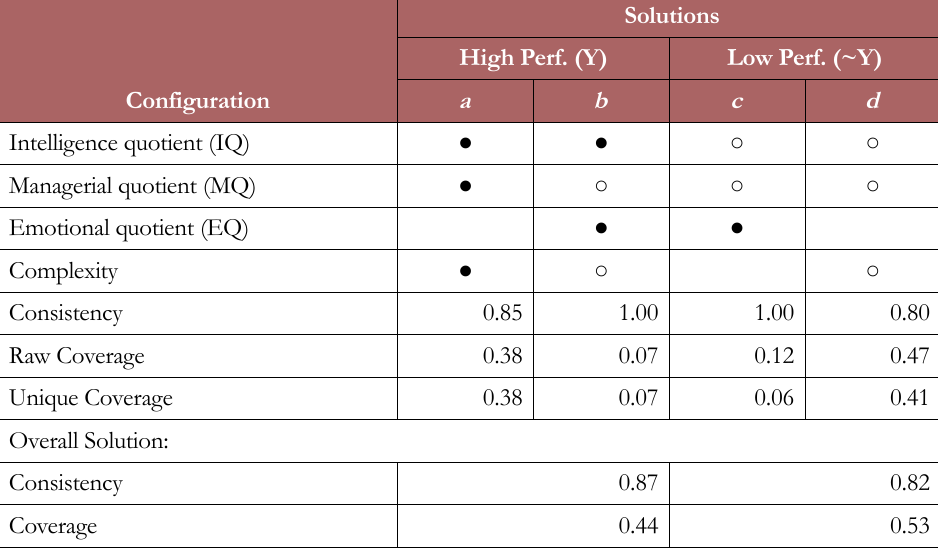
Table 11. Project Complexity as a Moderating